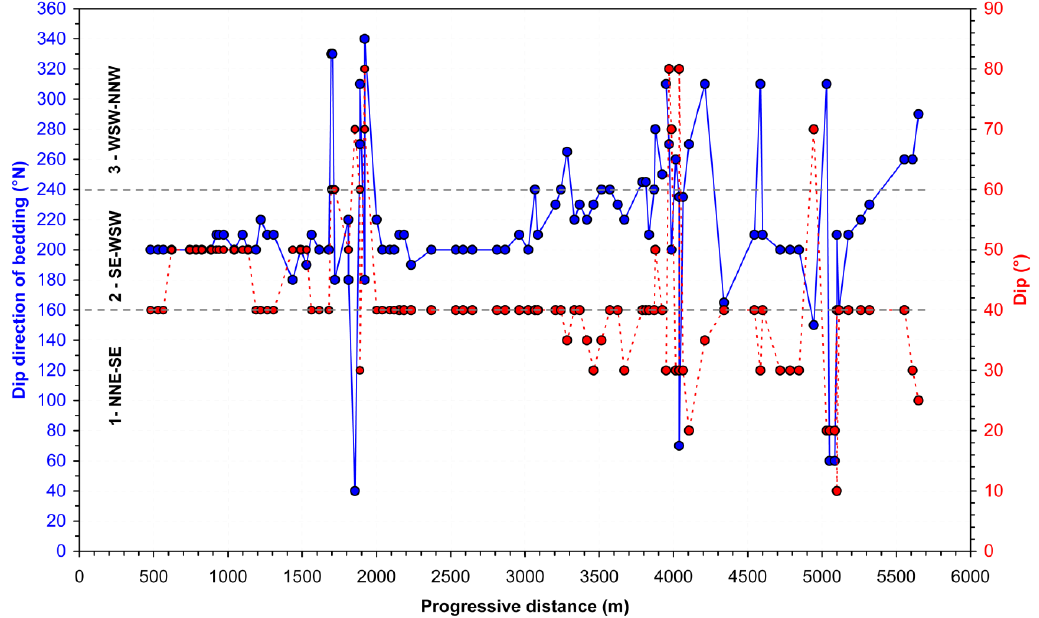
Fig. 7. Bedding attitude along the coastline from Rapallo to Chiavari. Three structural domains with different bedding attitude were recognised.